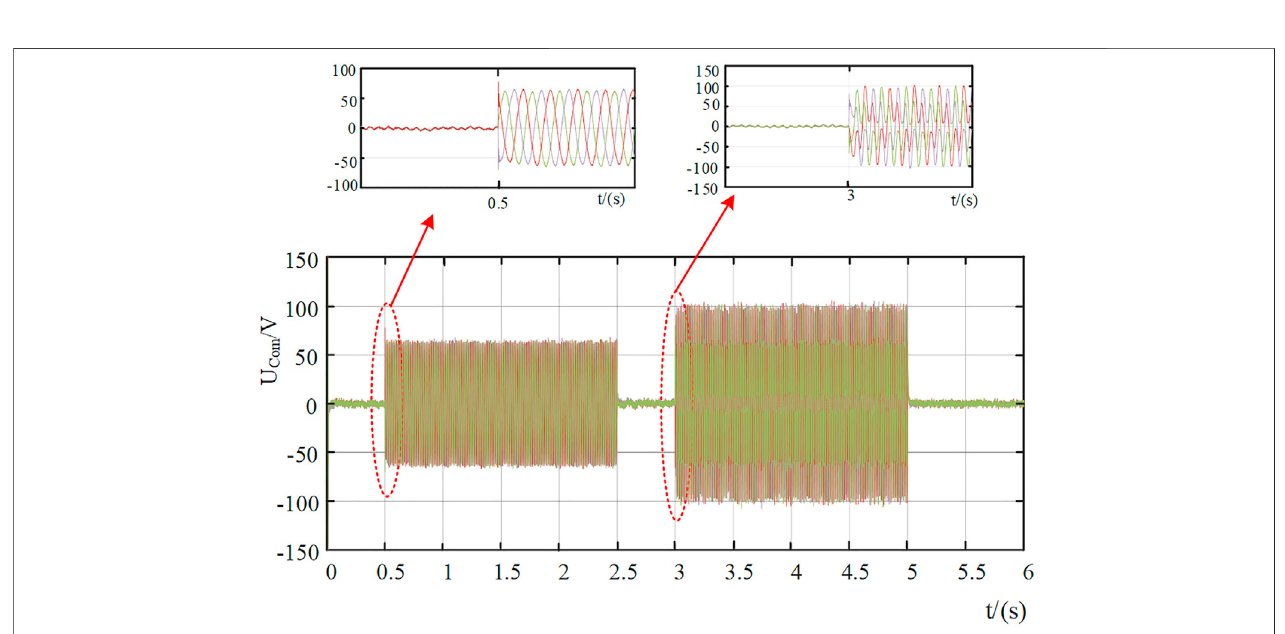
FIGURE 7 | Compensation voltage of voltage